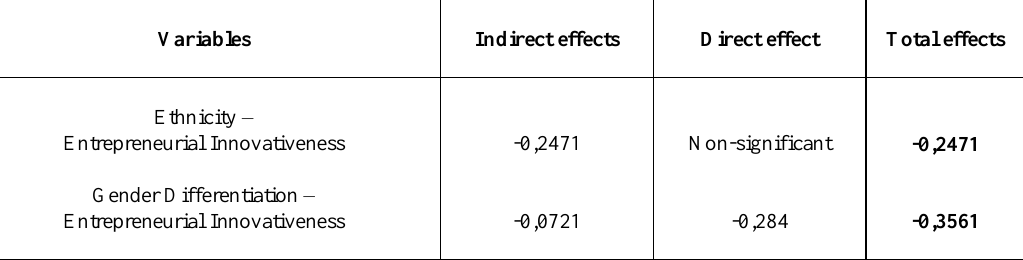
Table 4: Total effects of Ethnicity and gender differentiation on entrepreneurial